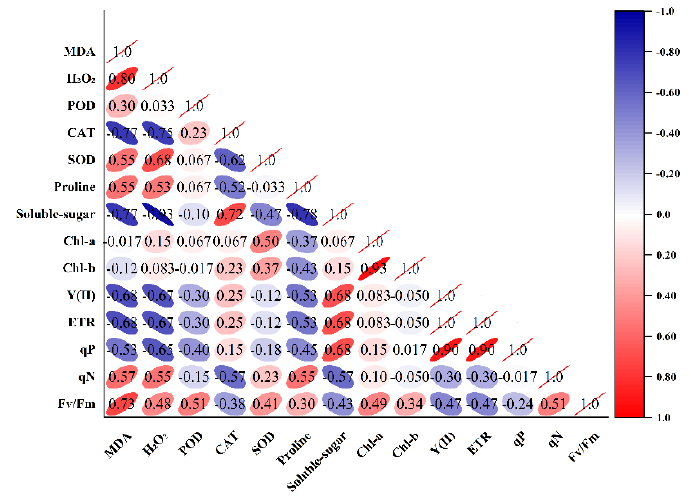
Figure 4. Matrix of correlation for response indexes of K. obovata seedlings under upwelling. MDA, malondialdehyde activity; H 2 O 2 , hydrogen peroxide; POD, peroxidase; CAT, catalase; SOD, super- oxide dismutase; Chl a , chlorophyll a; Chl b , chlorophyll b; Fv/Fm, ratio of variable and maximal fluorescence; Y(II), effective quantum yield of photosystem II; ETR, electron transport rate; qP, photochemical quenching coefficient; qN, non-photochemical quenching coefficient.